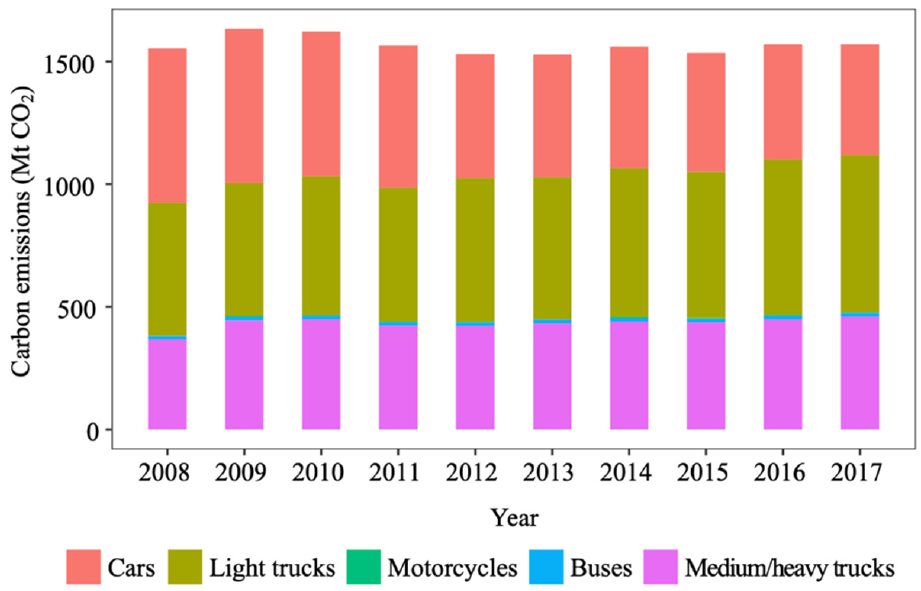
Figure 1. CO 2 emissions of the U.S. road transport sector.